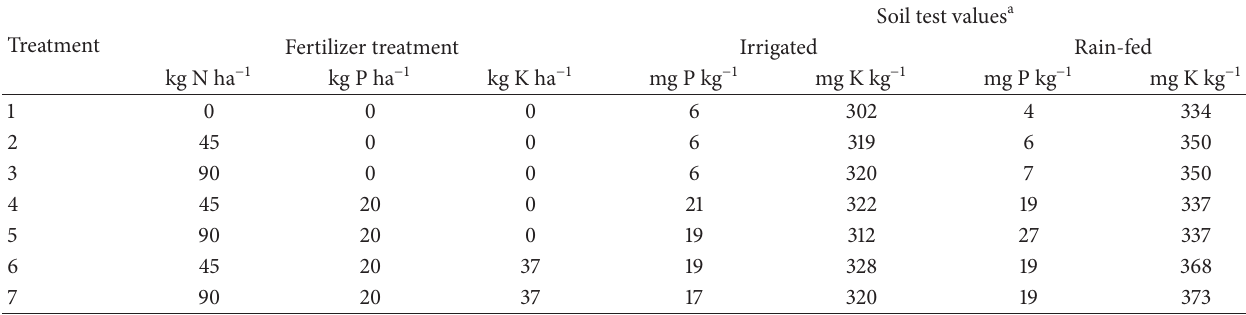
Table 1: Fertilizer rates and average soil test P and K for treatments in this study. N fertilizer was applied as urea (46-0-0) either preplant or midseason depending upon subplot assignment. P and K fertilizer treatments were all applied preplant as triple super phosphate (0-20-0) and muriate of potash (0-0-50),